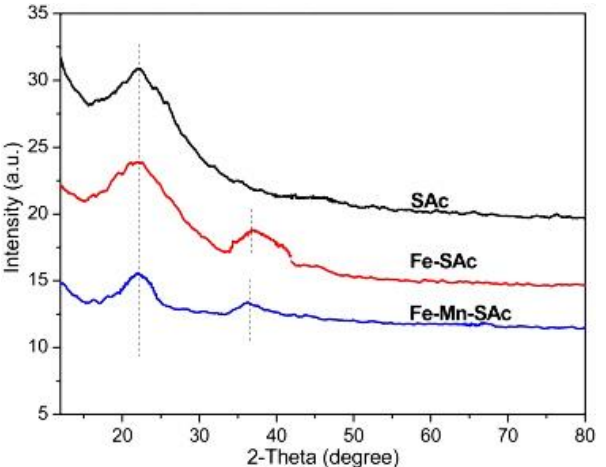
Figure 3. XRD analysis for Sac, Fe-Sac and Fe-Mn-Sac. Reprinted from Xiong et al. [23] Copyright 2021 Elsevier. (Xiong et al., 2017).